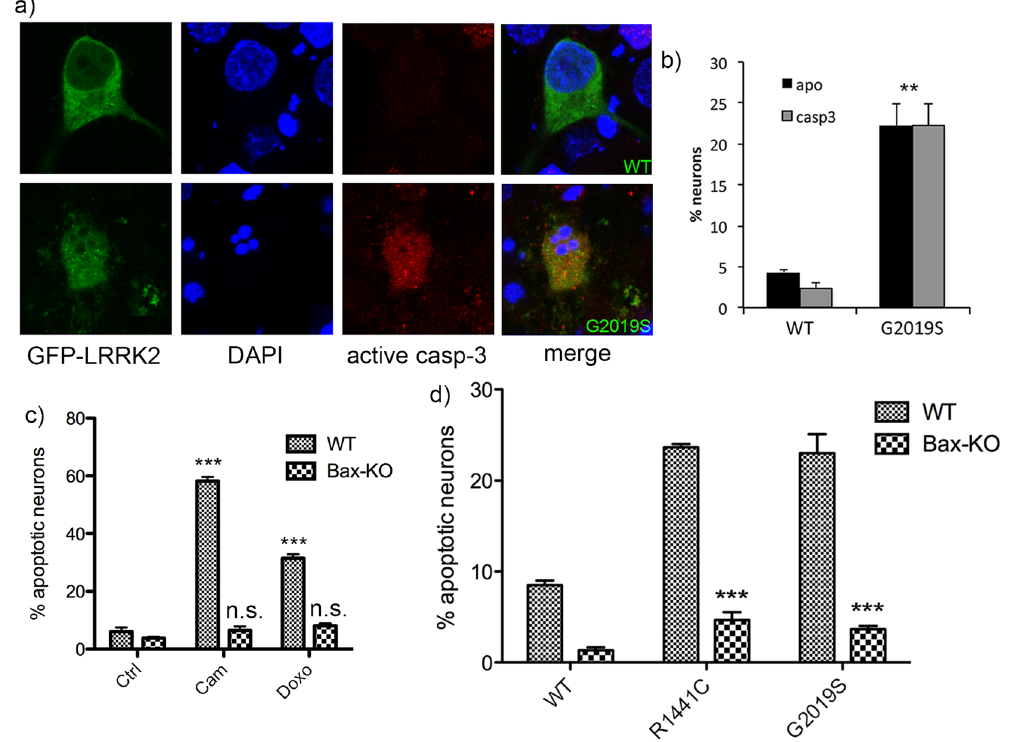
Figure 1. Genetic deletion of Bax prevents mutant LRRK2 induced neuronal death. Primary embryonic cortical neurons are derived from WT mice or mice lacking the pro-apoptotic protein Bax, and transiently transfected with GFP-tagged WT or mutant LRRK2 (R1441C, G2019S). ( a ) A representative image showing typical morphological features of apoptotic neurons expressing mutant LRRK2; that are positive for active caspase-3 (casp3) and display condensed and fragmented nuclei. ( b ) Quantification of apoptotic neuronal death (apoptotic nuclear profiles, “apo”; and active caspase-3 positive neurons, “casp3”) from cultures depicted in ( a ); ** p < 0.01 in comparison to WT transfected neurons. ( c ) Primary neurons were prepared from WT mice or mice deficient in Bax, and treated with the topoisomerase I inhibitor camptothecin (“cam”, 5 μ M, 18 hr), or doxorubicin (“doxo”, 10 ng/ml, 36 hr). Cells were fixed and processed for apoptotic nuclear counts. ( d ) Primary cortical neurons were prepared from WT mice or mice deficient in Bax, and transiently transfected with WT, R1441C, or G2019S LRRK2. As before, the cultures were fixed and the percentage of LRRK2-positive neurons that displayed apoptotic nuclear features was determined. The absence of Bax significantly protected neurons from death induced by mutant LRRK2. *** p < 0.001 compared to WT neurons expressing R1441C- or G2019S-LRRK2. Each data point represents the mean + / − SEM from 3–4 independent transfections from a representative culture. Cultures were repeated at least 3 times with similar